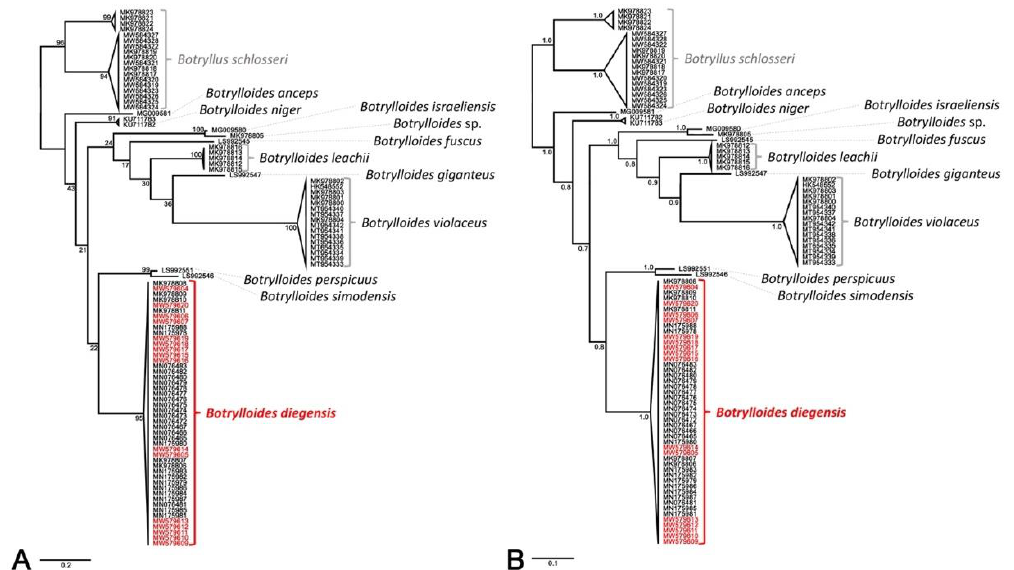
Figure 4. Phylogenetic trees constructed by the maximum likelihood ( A ) and Bayesian inference methods ( B ) for B. diegensis , other 10 Botrylloides species, and B. schlosseri (outgroup).